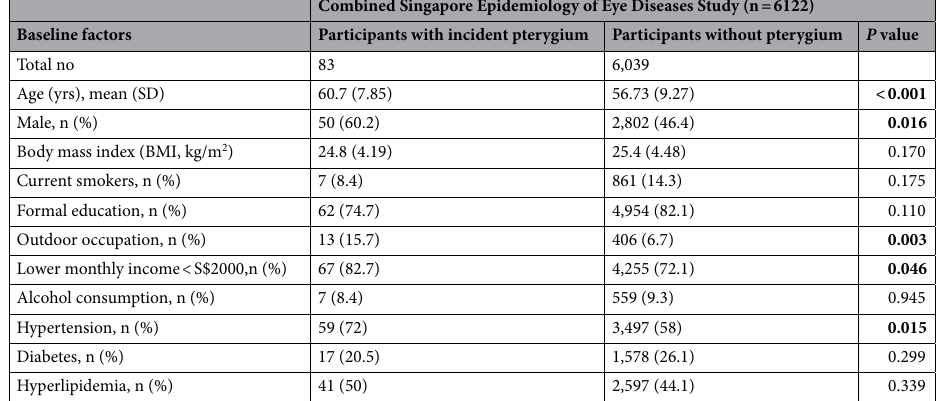
Table 1. Comparison of baseline characteristics between participants with and without incident pterygium. P value was calculated based on chi-square test or independent t-test, where appropriate.